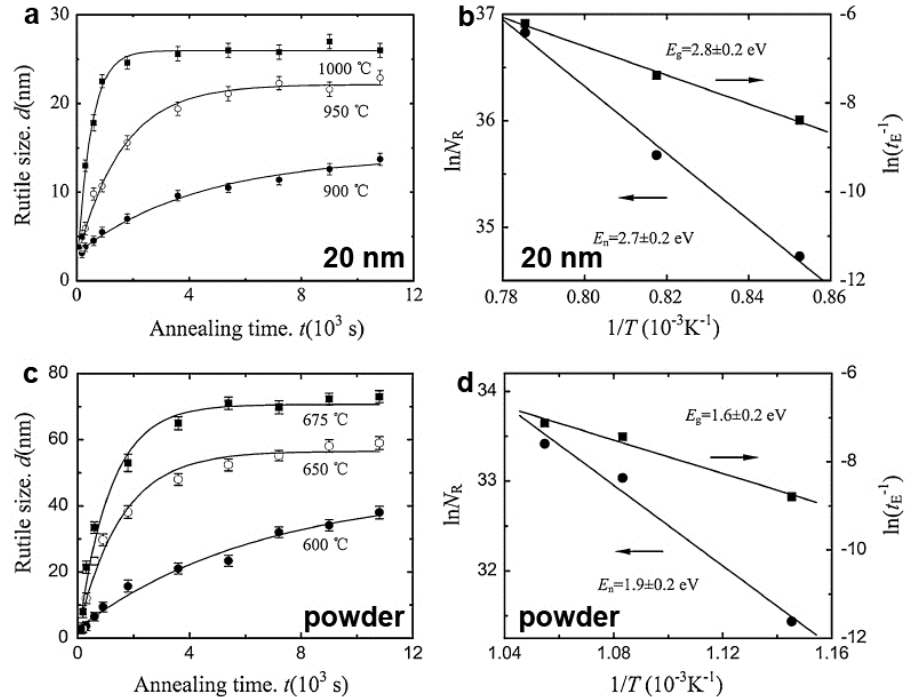
Figure 10. Nucleation and growth kinetics of nanocrystalline anatase to rutile. Annealing time dependence of the size of the rutile in the ( a ) nanowire and ( c ) free-state powders at different temperatures; Annealing temperature variations of the nucleation rate (NR) and the growth saturation rate t E − 1 for rutile in the ( b ) nanowire and ( d ) free-state powders, respectively (Reproduced with permission from [16], Copyright Springer, 2012).